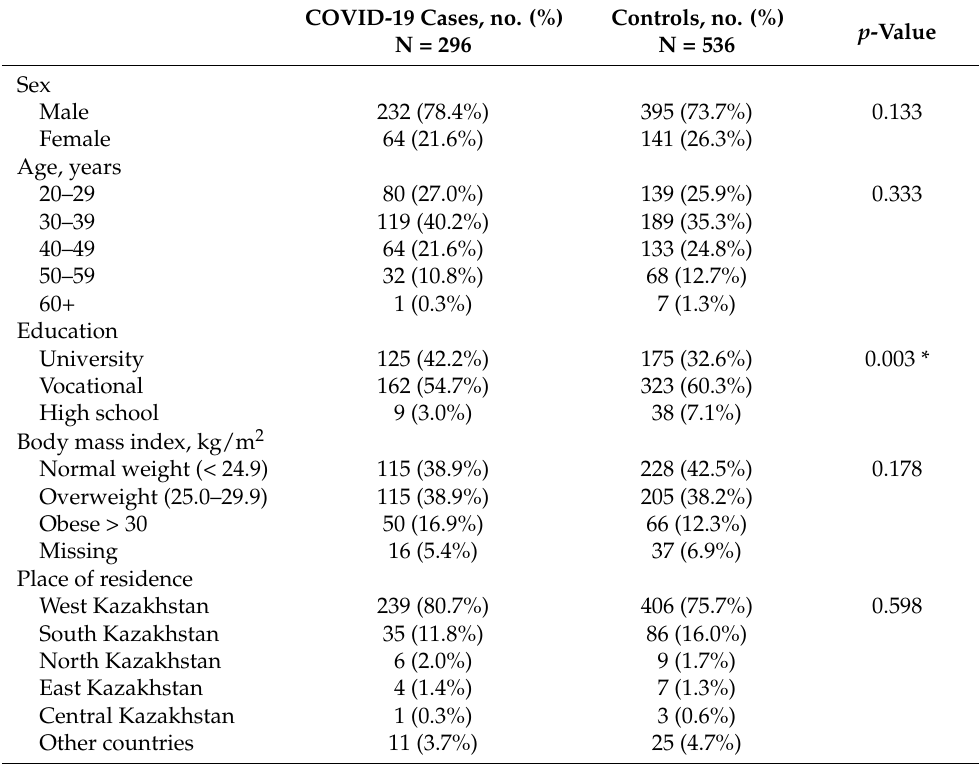
Table 1. General characteristics of the study population in Tengizchevroil, Kazakhstan